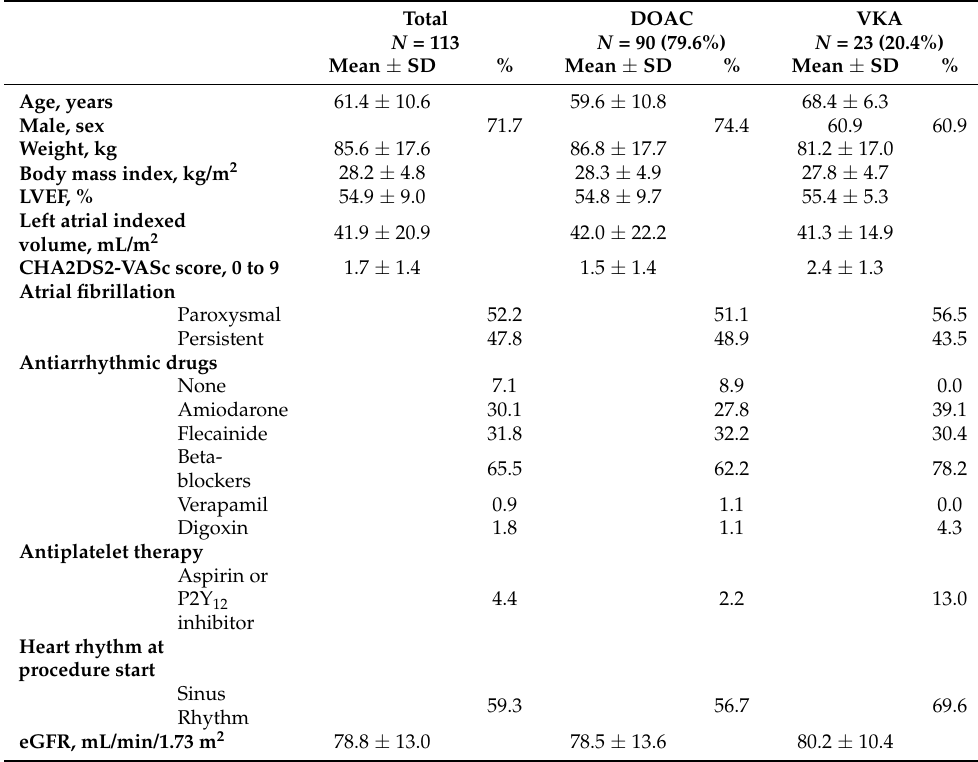
Table 1. Population characteristics. Continuous variables are expressed by mean and standard deviation (SD) and categorical variables by percentages. LVEF = Left ventricle ejection fraction, Egfr = estimated glomerular filtration